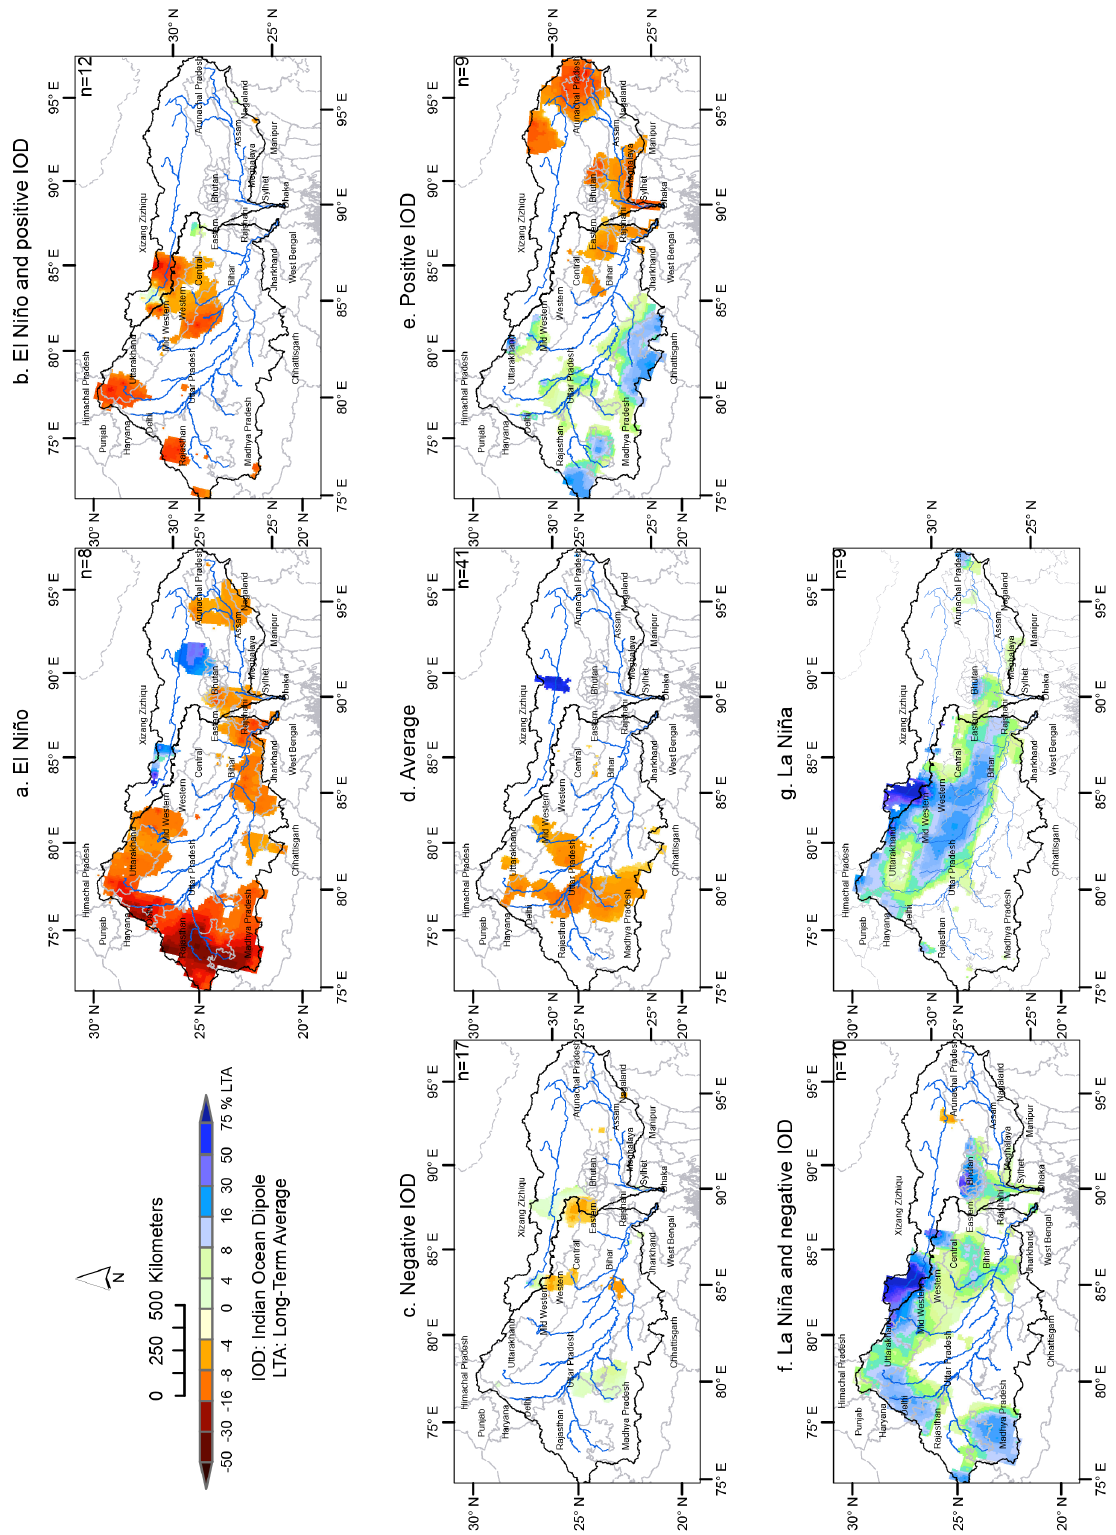
Figure 3. Composite of the spatially distributed mean June–October precipitation anomalies (% of LTA) when El Niño, La Niña, and positive or negative IOD occurred, co-occurred, or did not develop. The number of observed years for each ENSO–IOD combination is indicated with n . The only anomalies shown are those significantly different from the long-term variance as determined by Monte Carlo testing and a two-tailed t test at 80% confidence